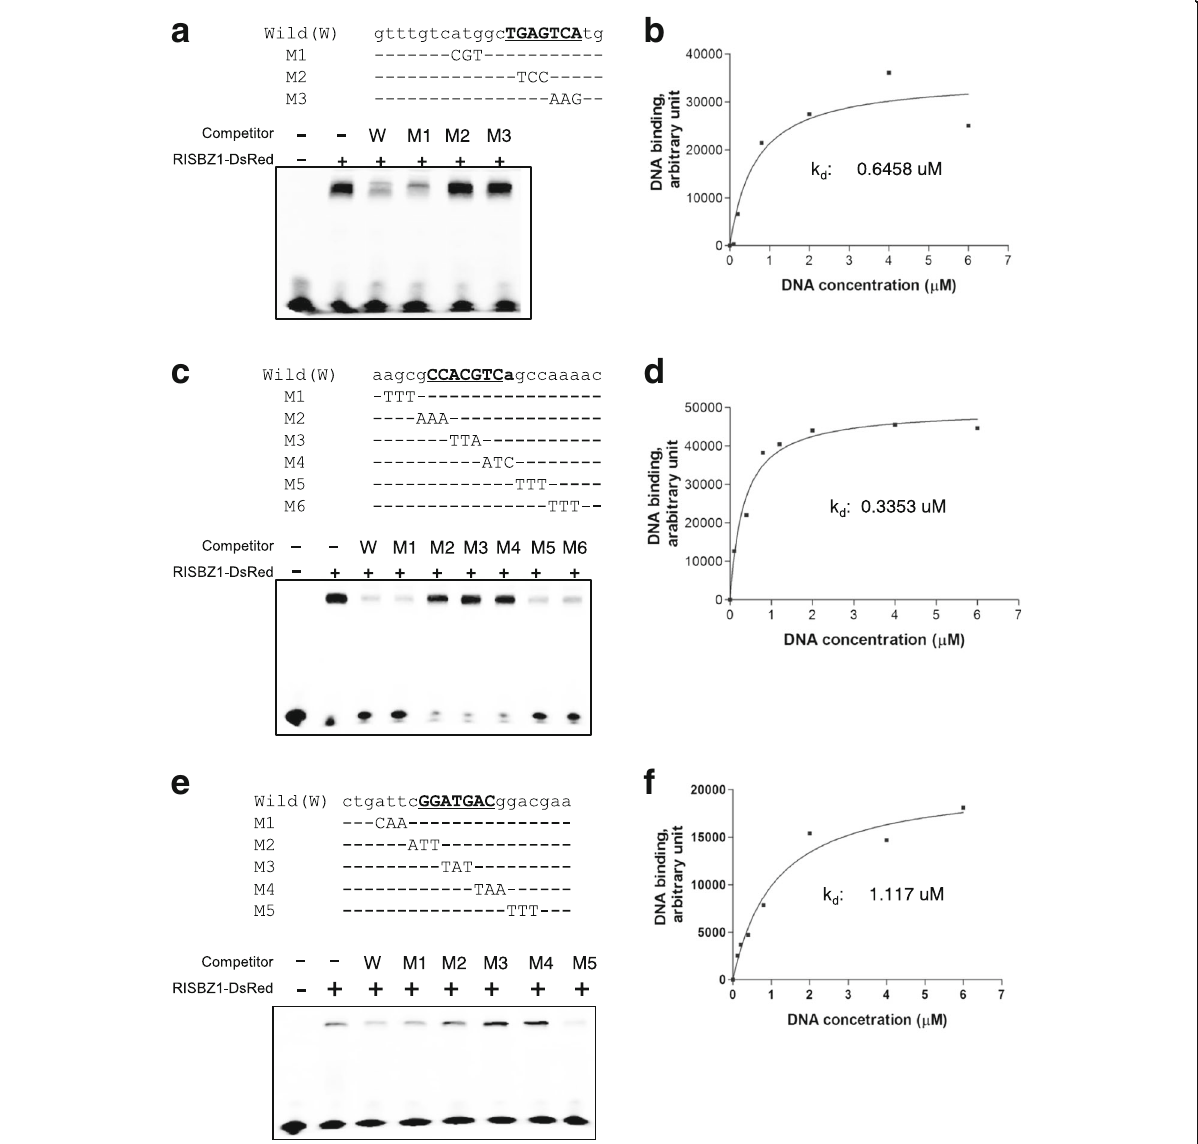
Fig. 3 Identification of OsSMF1 binding motifs in vitro. a, c, e EMSA-based competition analysis of OsSMF1. Sequences of oligonucleotides used as probes and competitors are depicted. Wild type, 21-bp sequences containing the GCN4 ( a ), ACGT ( c ), and ATGA motifs ( e ); and M1 to M6, 21-bp sequences with three nucleotide mutations. The GCN4, ACGT, and ATGA motifs are underlined. The OsSMF1-DsRed fusion protein was used for EMSA with the 21-bp sequences. Competitors were added in 100-fold molar excess. Lane 1, no protein; Lane 2, no competitor; and lanes 3 to 9, with competitors. b, d, f Accurate determination of the dissociation constant K d by gel shift assays using SYBR Gold. The DNA-binding band intensities determined using Gel-Pro Analyzer program were plotted against the various DNA substrate concentrations. The measured K d values were 0.6458 μ M for the binding of OsSMF1 to the GCN4 motif ( b ), 0.3353 μ M for ACGT ( d ), and 1.117 μ M for ATGA ( f